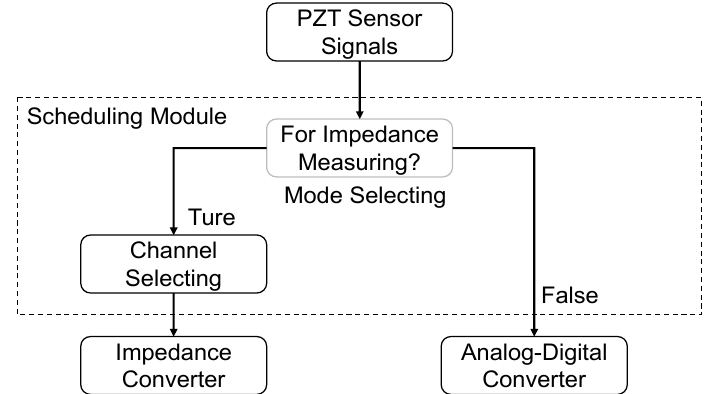
Figure 2. The hardware frame for the scheduling module.